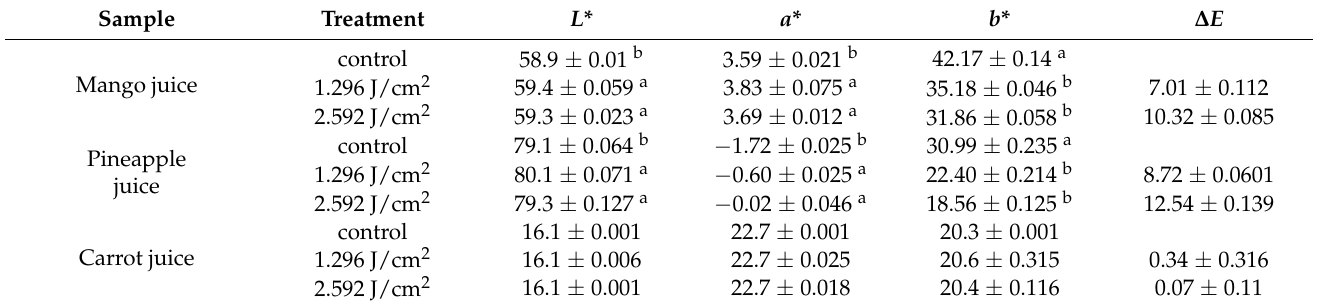
Table 2. Estimated color parameters for untreated and light-exposed juice (mango, pineapple, and carrot juice) for 1.296 and 2.592 J/cm 2 light dose,